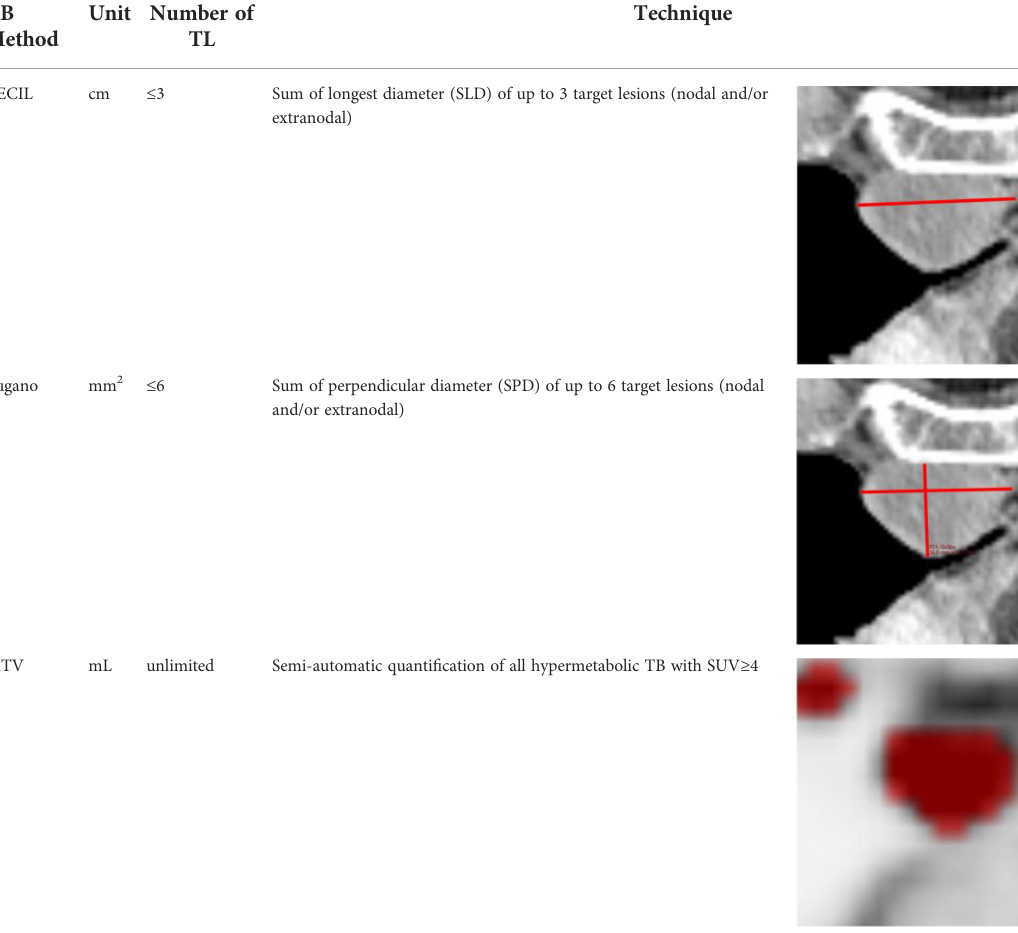
TABLE 1 Methods of Tumor Burden